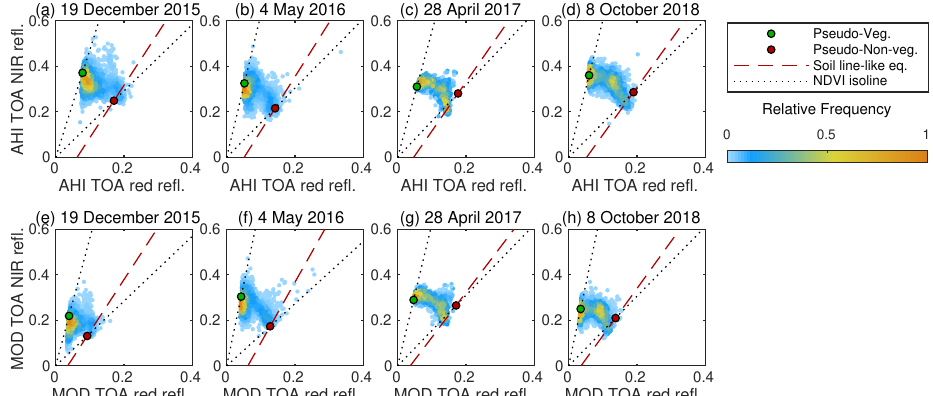
Figure 10. Density scatter plot of the red and NIR reflectances (excluding water bodies) over the Tokai AHI and ( e – h ) correspond to MODIS. Green and brown circles indicate the pseudo-vegetation and non-vegetation endmember spectra. The brown dashed line was calculated using the soil line-like equations, and dotted lines indicate the NDVI isoline for the endmember spectra.